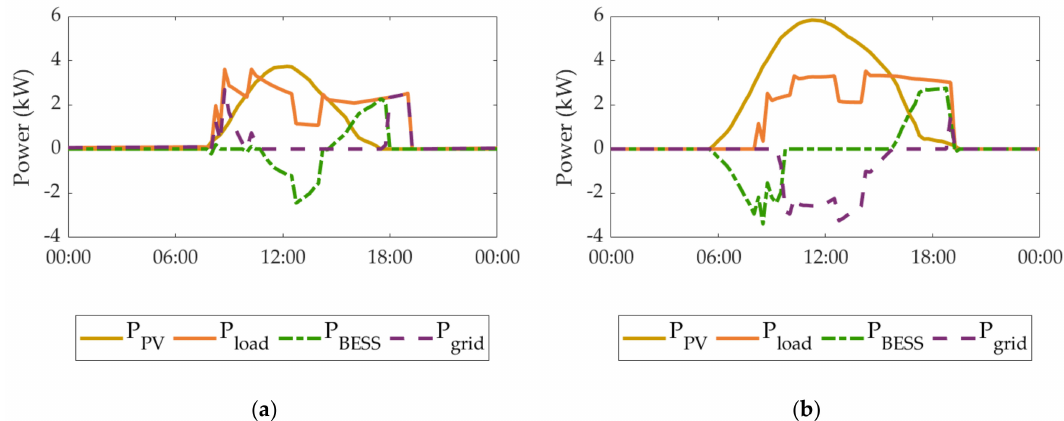
Figure 12. Power profiles of PV generation, electrical load, BESS charge/discharge and grid absorptions/injections during a typical winter ( a ) and summer ( b ) day for the